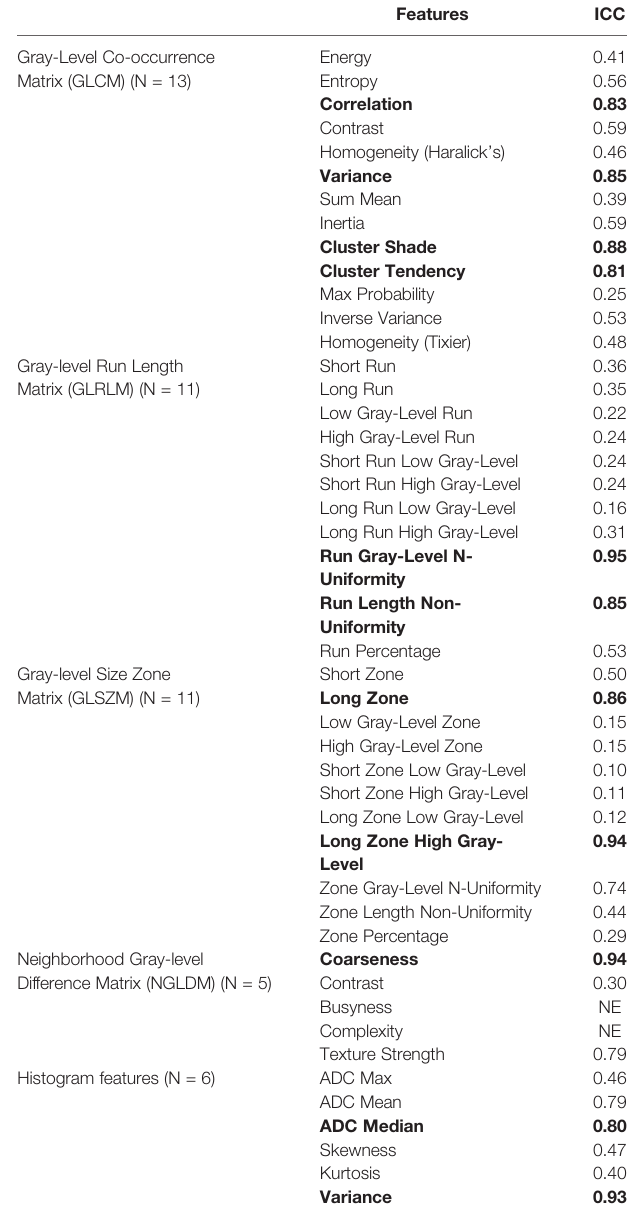
TABLE 2 | Nodal volumes for the evaluated patients.. TABLE 3 | Intra-class correlation coef fi cient (ICC) for texture features from baseline 1 and 2. ICC ≥ 0.8 are bolded.